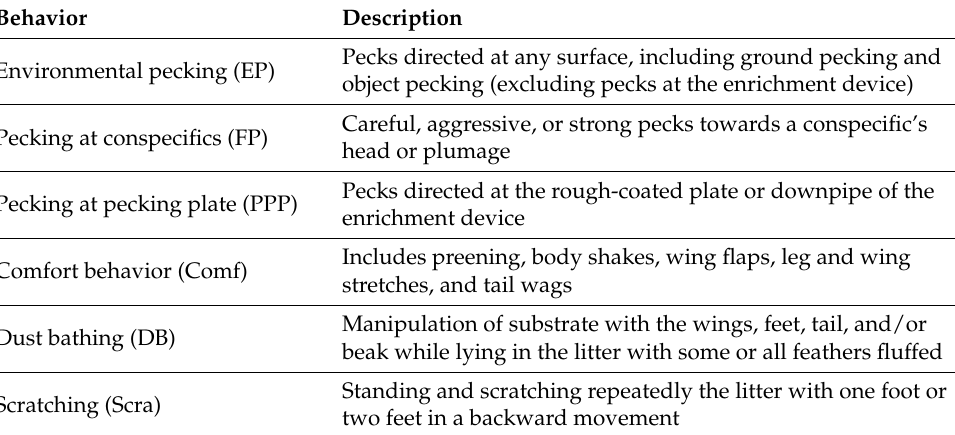
Table 2. Ethogram of continuous observations of general behavior in the winter garden and around the automatic enrichment device ([28],